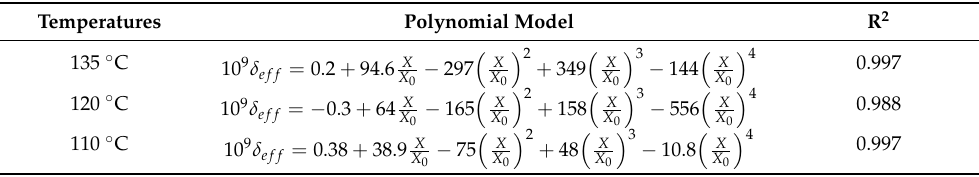
Table 4. Polynomial fitting of the effective moisture diffusivity δ eff .